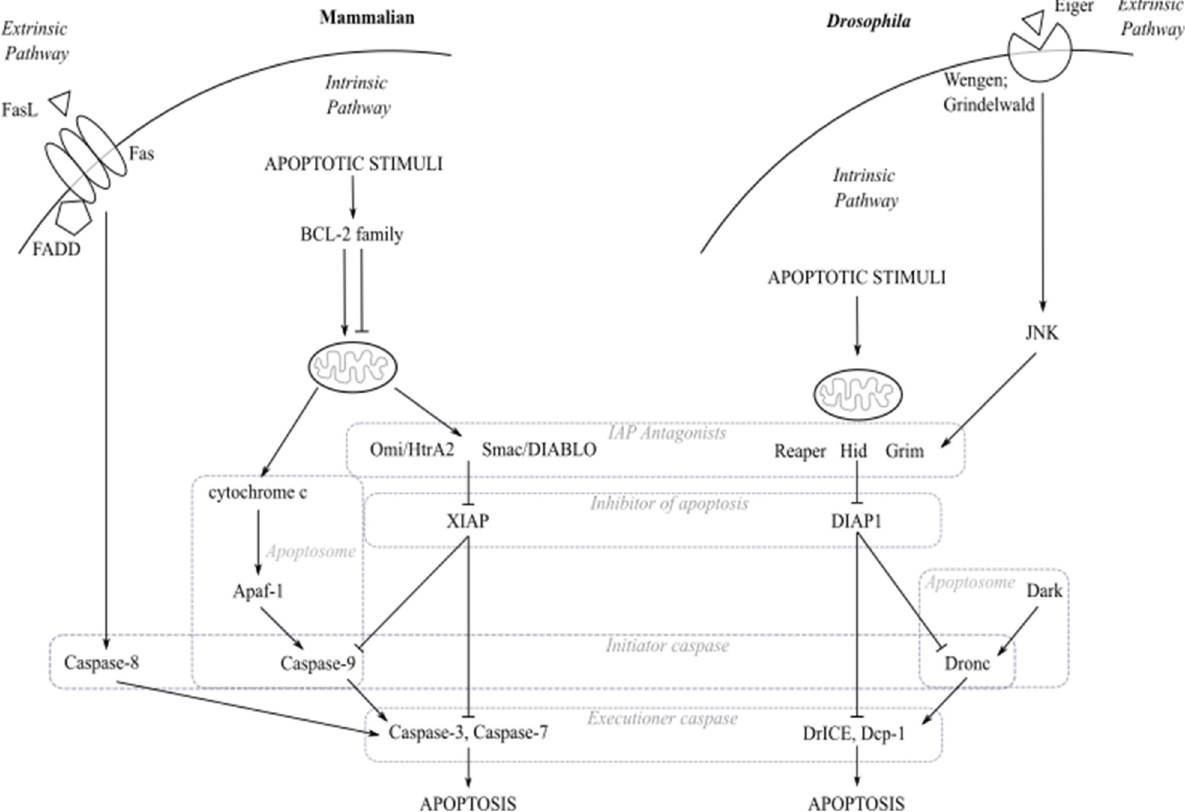
Figure 1. The core apoptosis pathway in mammals and Drosophila . During activation of the intrinsic apoptosis pathway in mammalian cells, apoptotic stimuli cause expression of pro-apoptotic BCL-2 family members resulting in the perturbation of the mitochondrial outer membrane and release of small molecules including cytochrome c, Omi/HtrA2 and Smac/DIABLO. Cytochrome c binds to Apaf-1 forming the apoptosome which recruits the pro-caspase-9 leading to its activation. Meanwhile, Omi/HtrA2 and Smac/DIABLO act as IAP antagonists to free caspases from the inhibition of apoptotic proteins such as XIAP. Active caspase-9 cleaves and activates caspase-3 and -7, allowing execution of apoptosis. The mammalian extrinsic apoptosis pathway is activated upon ligand binding to death receptor, e.g., Fas. Adaptor protein FADD recruitment to Fas forms the death-inducing signalling complex (DISC) which binds and activates caspase-8. Active caspase-8 cleaves and activates caspase-3 and caspase-7, allowing execution of apoptosis. In the intrinsic apoptosis pathway in Drosophila , apoptotic stimuli activate expression of pro-apoptotic proteins such as Reaper, Hid and Grim which need to localise to the mitochondria to become fully activated. These pro-apoptotic proteins release caspases from DIAP1 held inhibition. The initiator caspase Dronc then associates with the scaffold protein Dark to form an apoptosome-like complex. Active Dronc cleaves executioner caspases, DrICE and Dcp-1, which bring about apoptosis. The Drosophila extrinsic apoptosis pathway is activated by binding of Eiger to the death receptors Wengen or Grindelwald, resulting in activation of the JNK signalling pathway. Active JNK signalling induces expression of pro-apoptotic proteins, Hid and Reaper. The evolutionarily conserved core components in the apoptosis pathway are highlighted with the dashed line boxes.